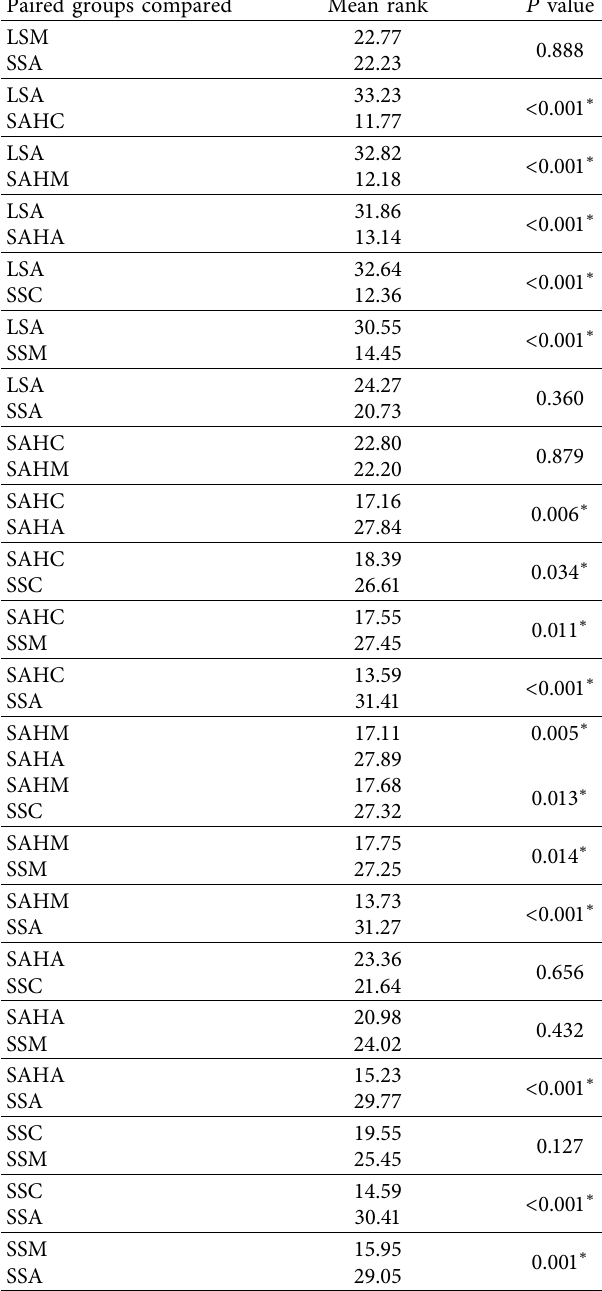
pairwise comparisons of the root areas were carried out by the Games–Howell test and the results are reported in Table 5. 3.5. Mode of Failure. Group and mode of failure were not signifcantly correlated, and the frequency of modes of failure was not signifcantly diferent among the groups ( P >